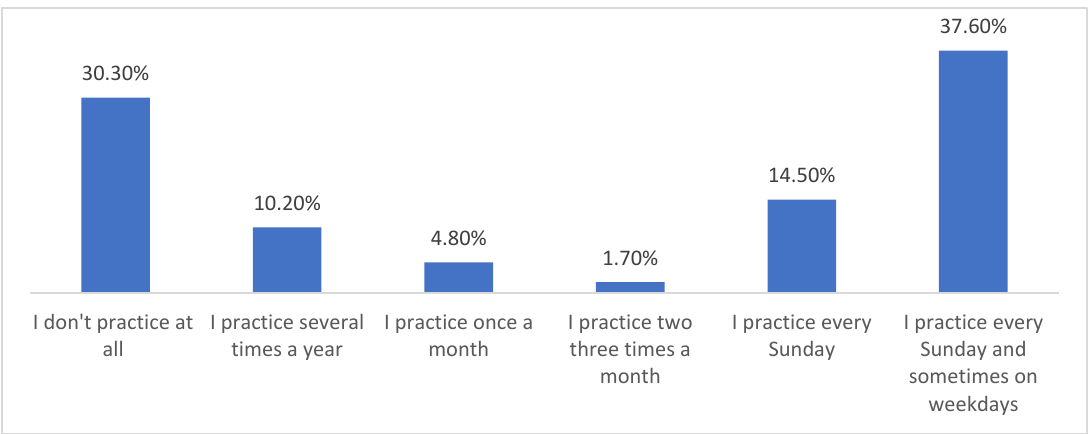
Figure 1. Characteristics of respondents in terms of declared frequency of religious practices.